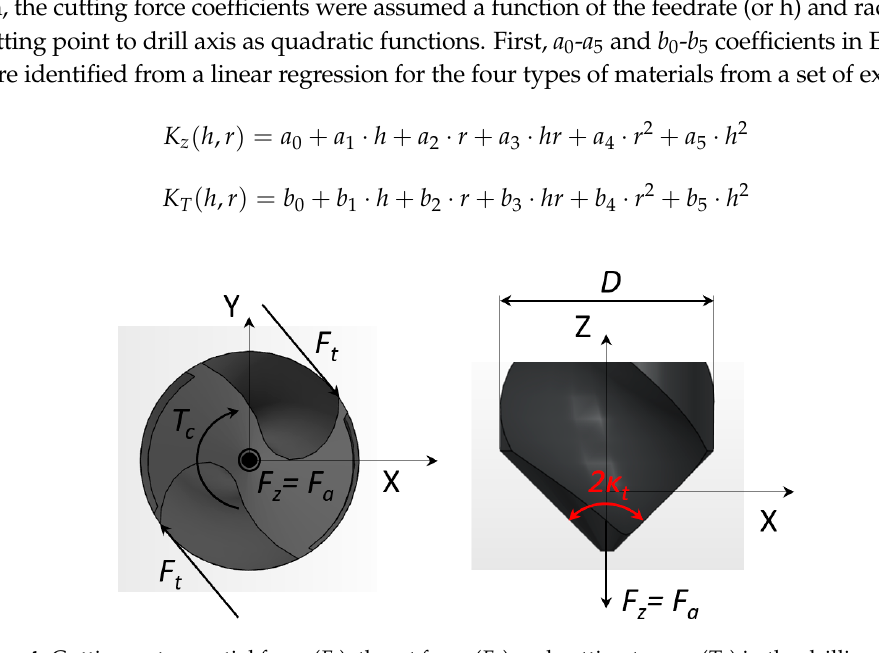
Figure 4. Cutting or tangential force ( F t ), thrust force ( F z ) and cutting torque ( T c ) in the drilling process; Drill bottom view ( left ) and front view ( right ).